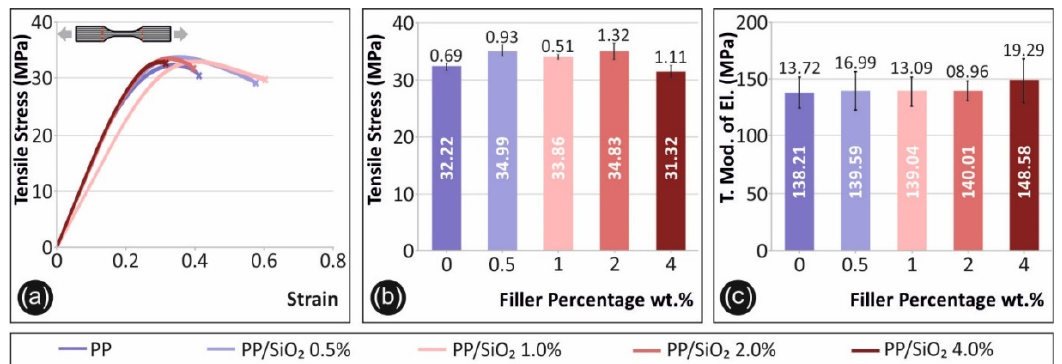
Figure 3. Tensile test results: ( a ) tensile stress (MPa) to strain (%) graph, for a characteristic specimen of each material fabricated, ( b ) average maximum tensile stress (MPa) and its deviation for the materials tested, ( c ) average tensile modulus of elasticity (MPa) and its deviation for the materials tested.